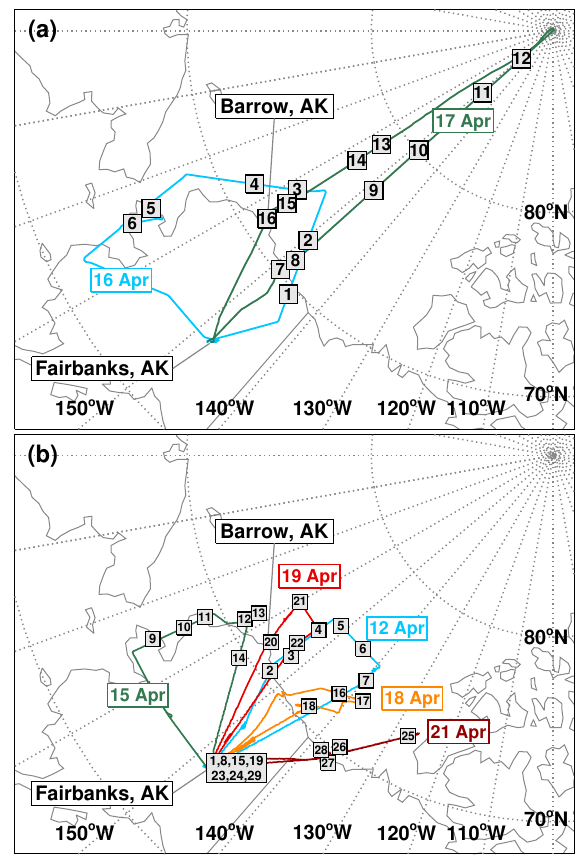
Fig. 1. Flight tracks (lines) and the locations (numbers) of BrO profiles measured by instruments on board the (a) NASA DC-8 aircraft during ARCTAS and (b) NOAA WP-3D aircraft during ARCPAC.